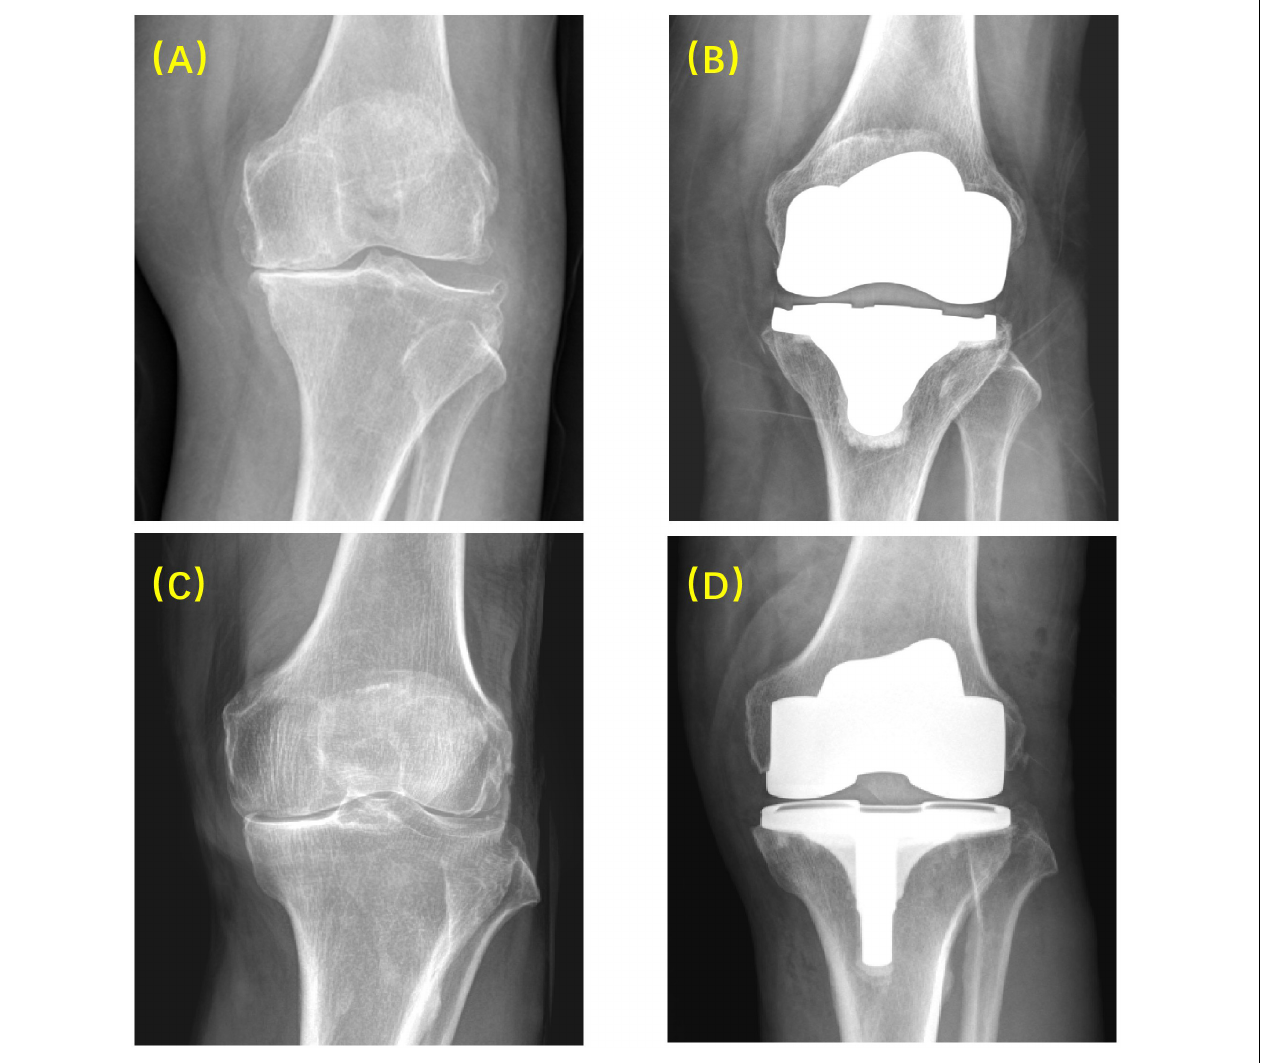
FIGURE 1 | Radiographic images before and after surgery using MP and PS prostheses. (A) Before MP TKA; (B) after MP TKA; (C) before PS TKA; (D) after PS